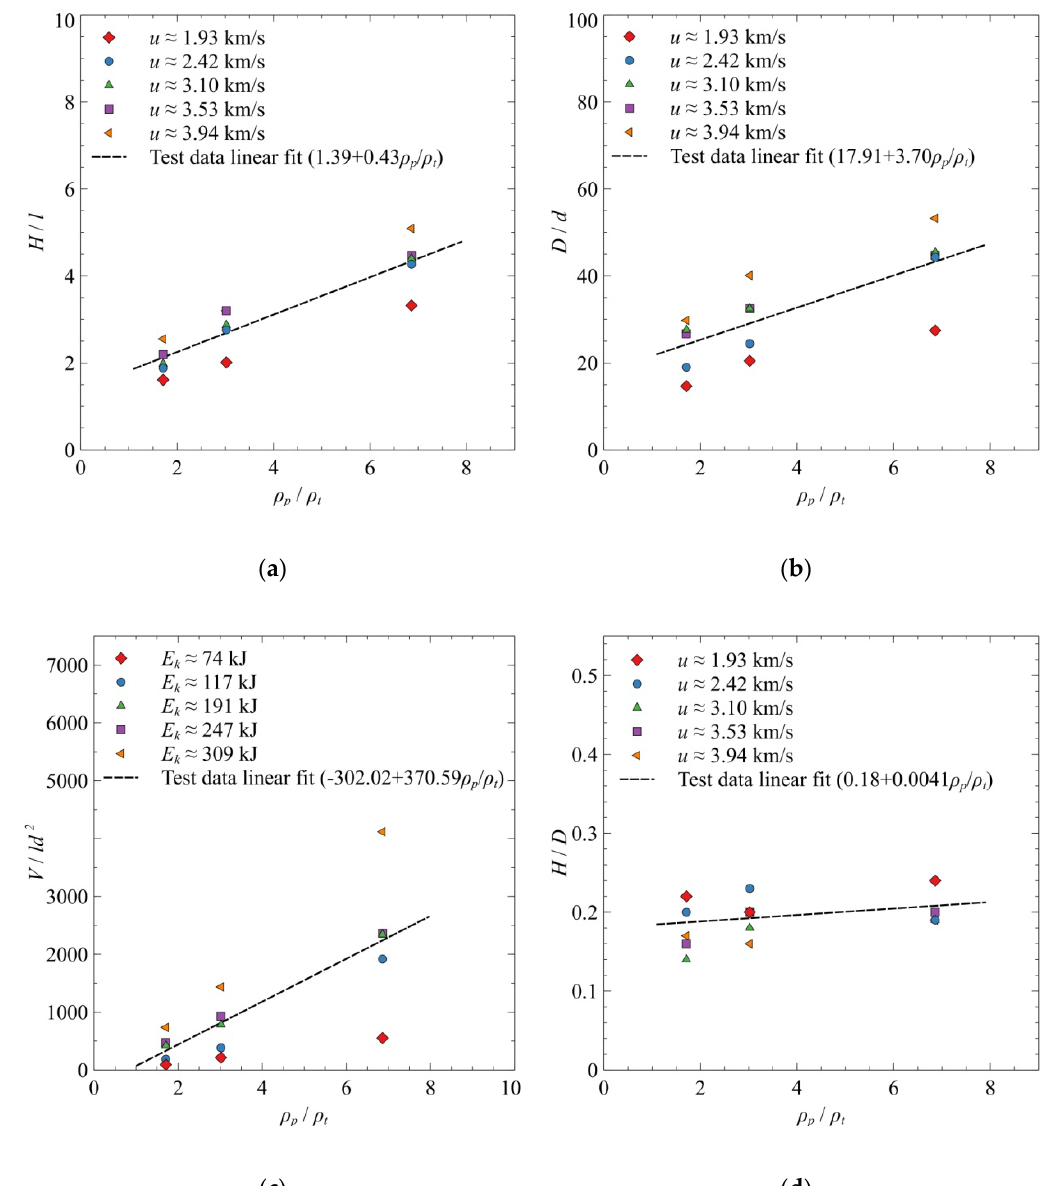
Figure 11. The influences of ρ p / ρ t on crater depth, diameter, volume, and crater H / D ratio: ( a ) dimensionless crater depth versus ρ p / ρ t ; ( b ) dimensionless crater diameter versus ρ p / ρ t ; ( c ) dimensionless crater volume versus ρ p / ρ t ; ( d ) crater H / D ratio versus ρ p / ρ t .